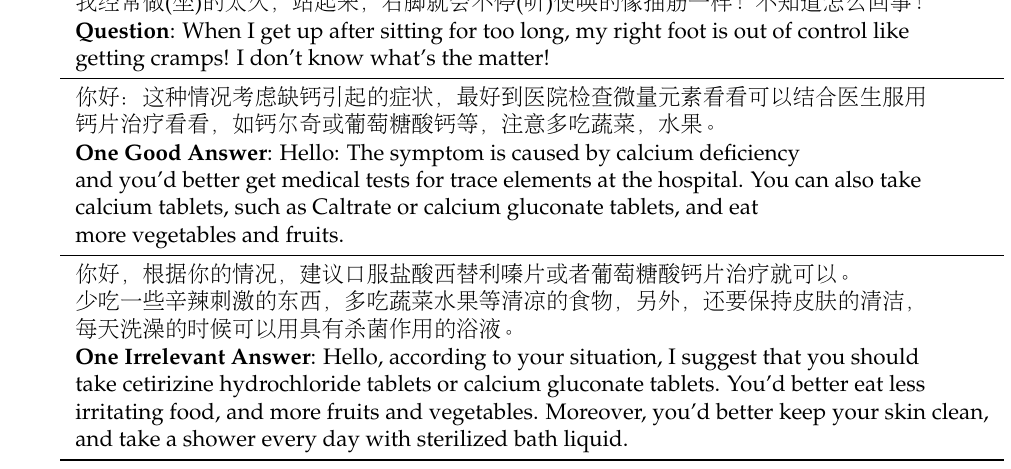
Table 1. An example of a question with its ground-truth answer and an irrelevant answer from the cMedQA